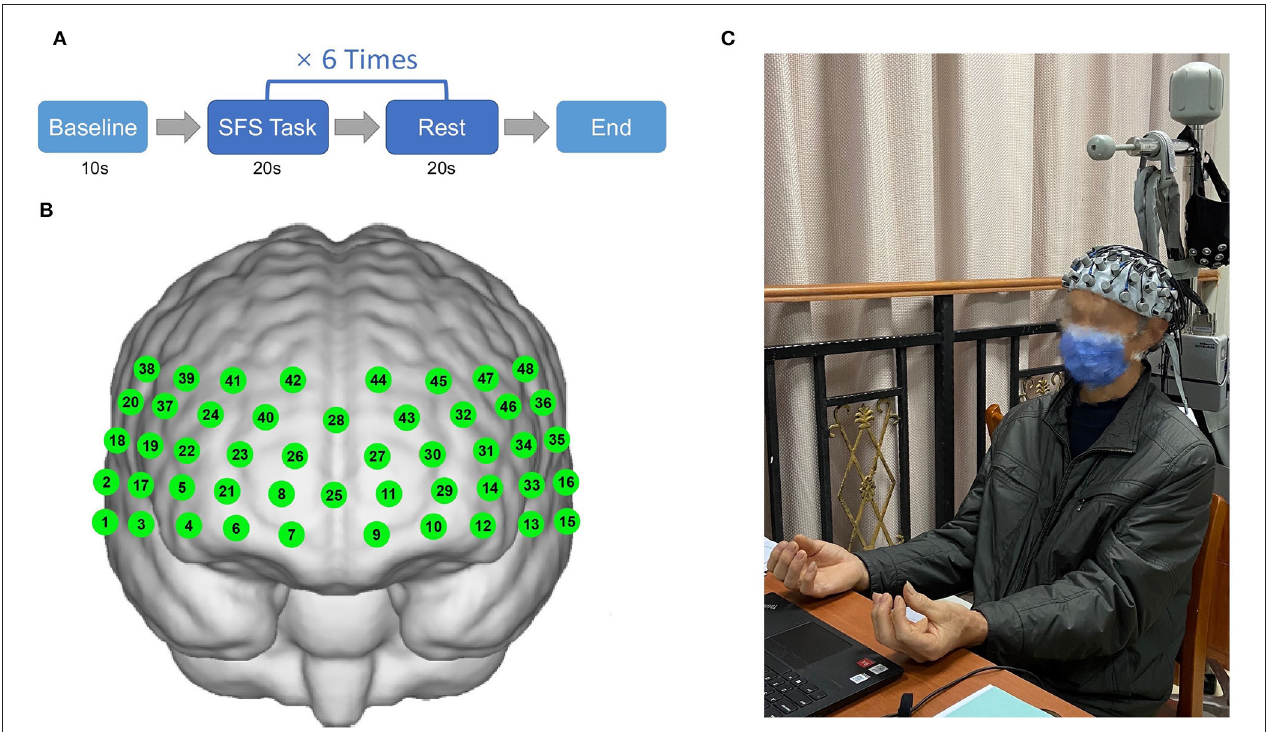
FIGURE 1 | Illustration of finger movement task (simple finger sequence) paradigm (A) and positions of 48 channels (B,C) (Informed consent was obtained from the patient). Broca’s Area (Broca’s. L) (channel 30, 31, and 32), left supplementary motor area cortex (SMA.L) (channel 46), and right subcentral area (SCA.R) (channel 17). For each